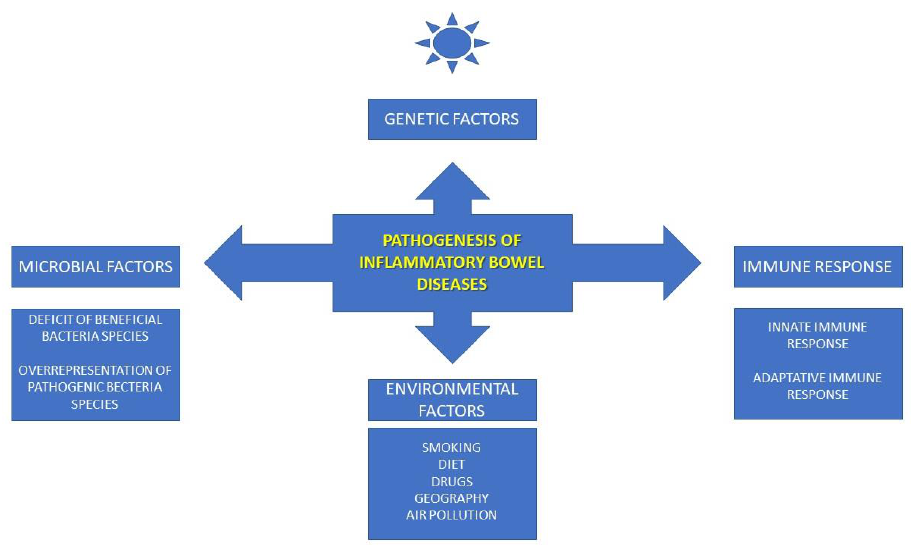
Figure 1. Pathogenesis of IBDs.